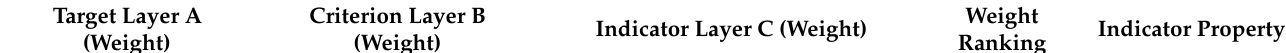
Table 5. Proposed evaluation system of a rural riparian landscape in Qingxi area (source: author).